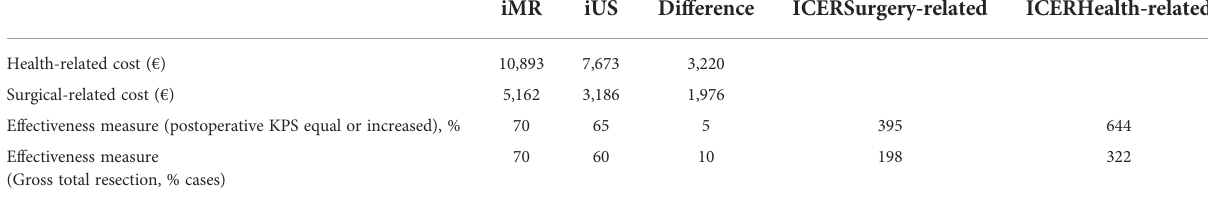
TABLE 4 Cost-effectiveness analysis.